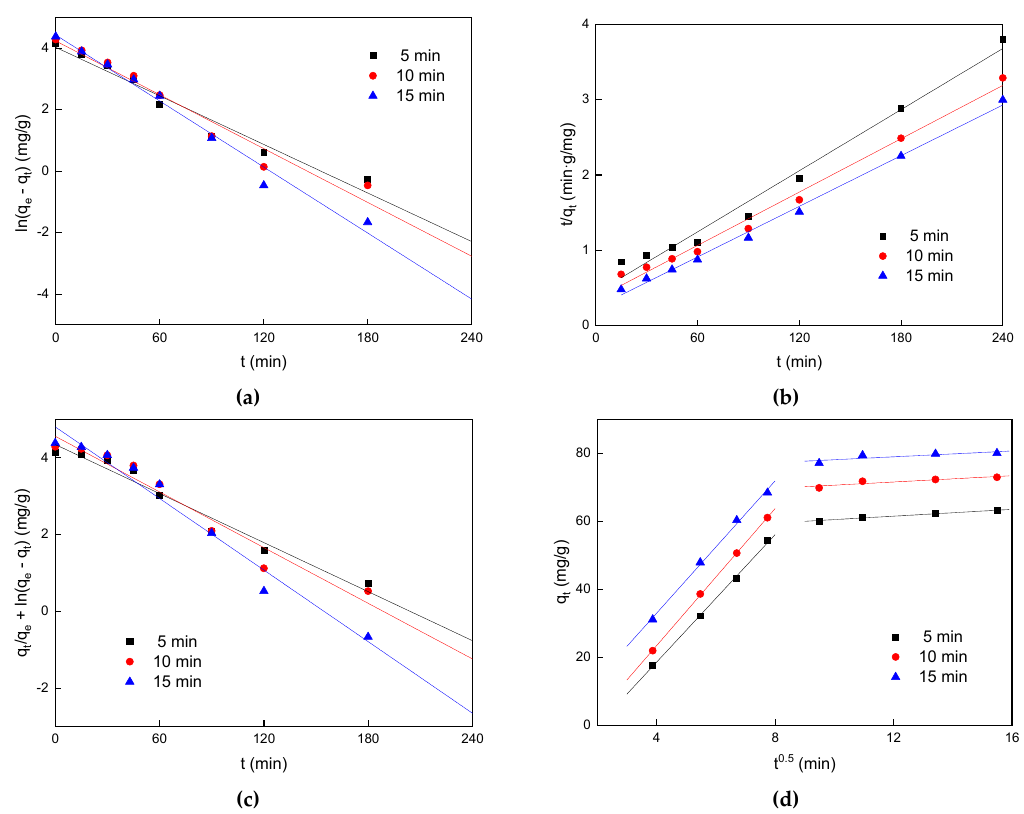
Figure 6. Effect of pyrolysis time on adsorption kinetics of char. ( a ) pseudo-first-order kinetics model; ( b ) pseudo-second-order kinetics model; ( c ) modified pseudo-first-order kinetics model; ( d ) intraparticle diffusion model.